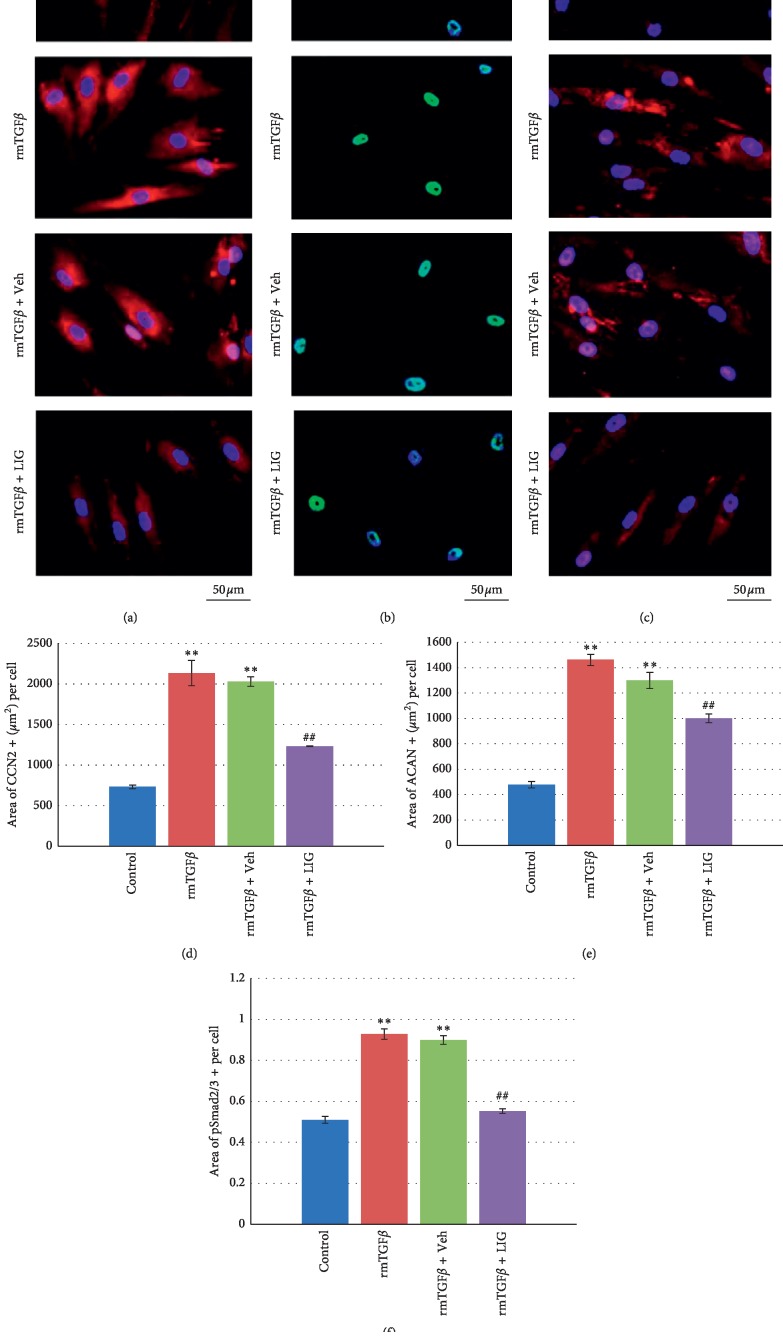
The effect of LIG on HNPC in vitro. (a–c) Representative immunostaining images of HNPC treated with 5 ng/mL rmTGFβ1 combined with or without 10−5 M LIG, or 0.01% DMSO (rmTGFβ1 + Veh) for CCN2 (a), pSmad2/3 (b), and ACAN (c). (d–f) Quantification of CCN2, pSmad2/3, and ACAN expressions in (a)–(c). Each column represents the mean ± SE of three independent experiments. ∗∗p < 0.01vs Control, ##p < 0.01vs rmTGFβ.